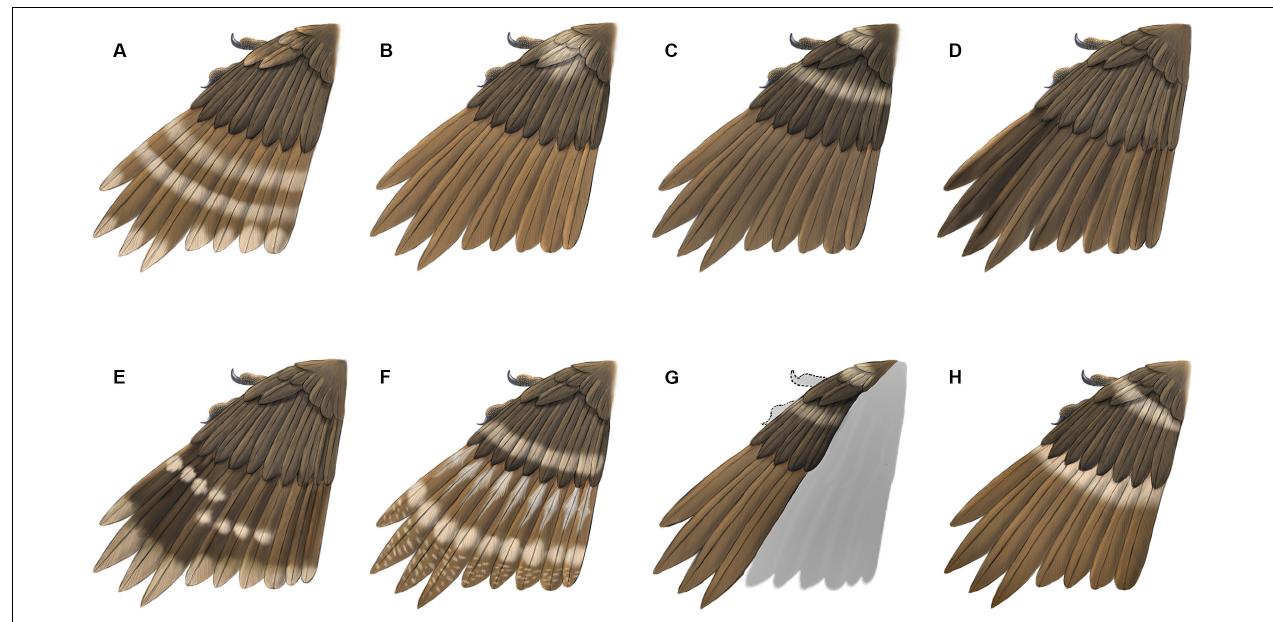
FIGURE 5 | Reconstructions of primary plumage color patterns known so far in enantiornithines from Burmese Amber. (A) HPG-15-1; (B) DIP-V-15100; (C) DIP-V-15101; (D) DIP-V-15105; (E) HPG-15-2; (F) LV-0321; (G) DIP-V-15102; (H)